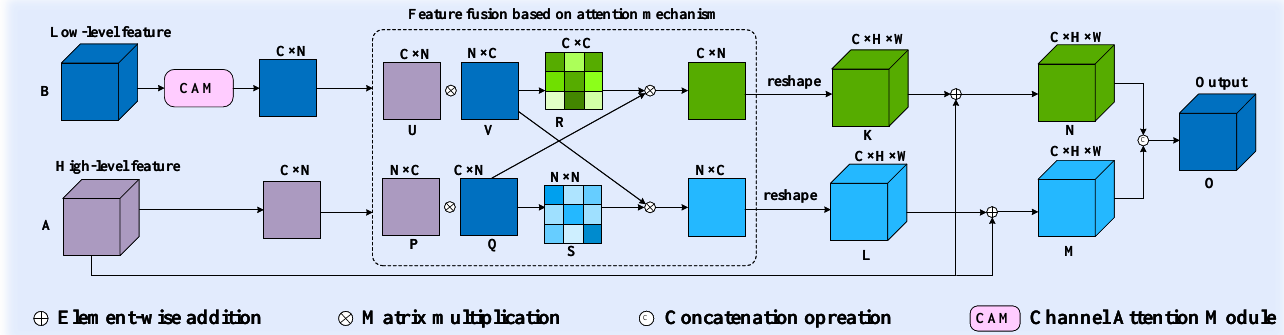
Figure 3. Overview of the proposed DAFFM. In order to make better use of multi-scale feature maps, we adopt the feature fusion module DAFFM based on spatial attention and channel attention mechanism to fuse the detail and semantic information for better segmentation results at the boundary. Benefiting from the detail and semantic information aggregating based on attention mechanisms, the semantic gap between different layers is reduced. In this way, we utilize the multi-scale feature maps more effectively.